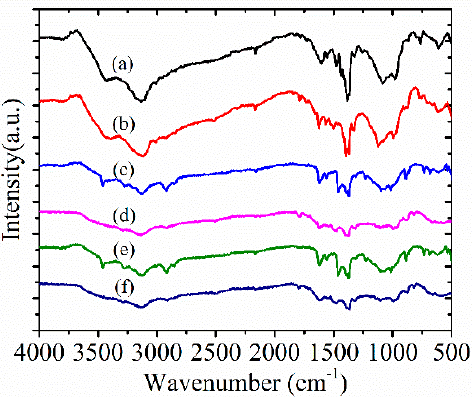
Figure 4. FT-IR spectrum of the reactant aminopyridine derivatives and the target azacyanine products: (a) 2-aminopyridine; (b) Azacyanine 1; (c) 5-Bromo-2-aminopyridine; (d) Azacyanine 2; (e) 4-Amino-3,5-bromopyridine; (f) Azacyanine 3. Table 1. The elements analysis results of products: Azacyanine 1, 2, and 3. Sample